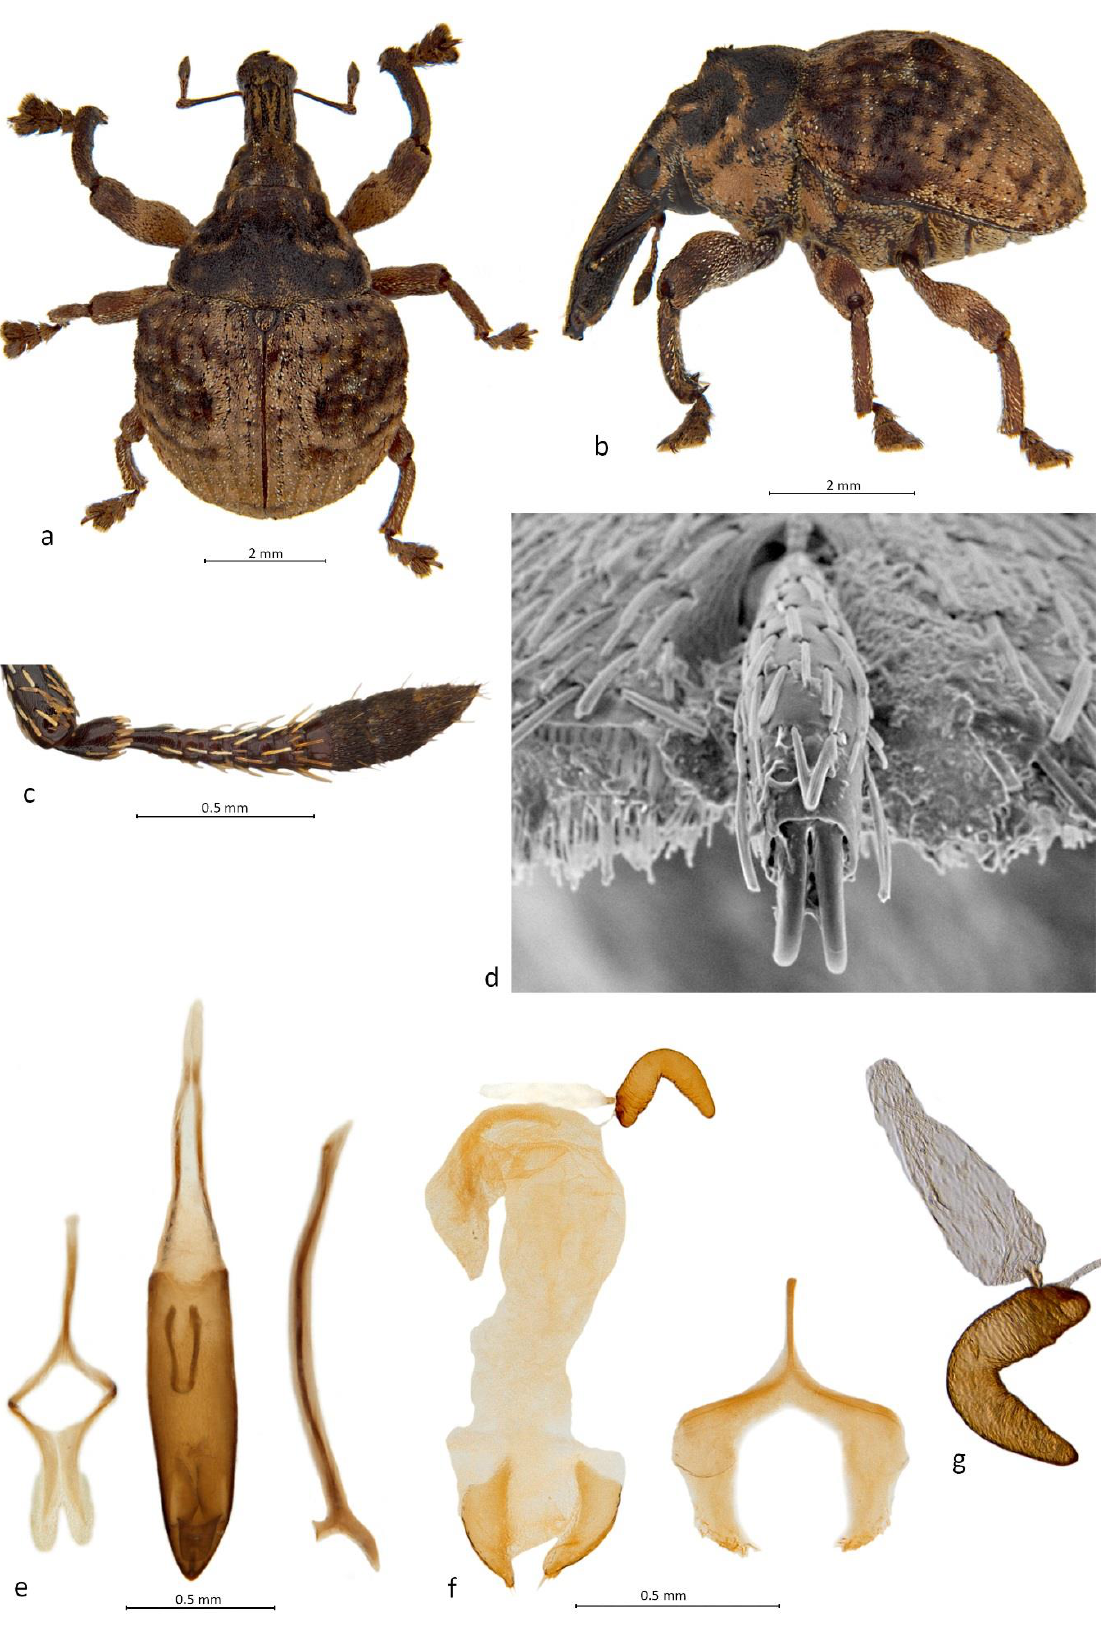
Figure 8. Habitus and diagnostic characters of Menechirus howdenae sp. n.: ( a ) habitus of male, dorsal view; ( b ) habitus of male, left lateral view; ( c ) right antenna, male, dorsal view; ( d ) tarsite 3 with onychium, apical view; ( e ) genitalia, male, dorsal view; ( f ) genitalia, female, dorsal view; ( g ) spermatheca with gland.